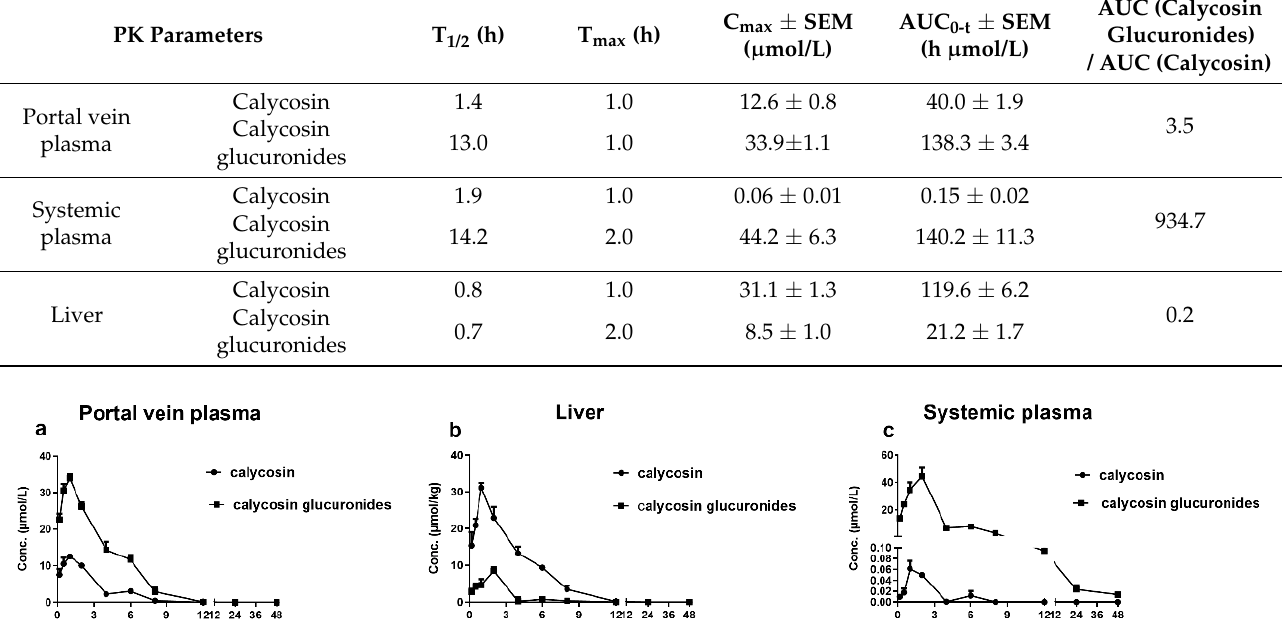
Figure 5. Mean concentration-time curves of calycosin and calycosin glucuronides in portal vein plasma ( a ), the liver ( b ), and systemic plasma ( c ) after oral administration of 76.4 mg/kg calycosin to rats (n = 5, mean ± SEM). Table 2. PK parameters of calycosin and calycosin glucuronides in the portal vein plasma, systemic plasma, and liver after oral administration of calycosin at 76.4 mg/kg in rats (n=5).